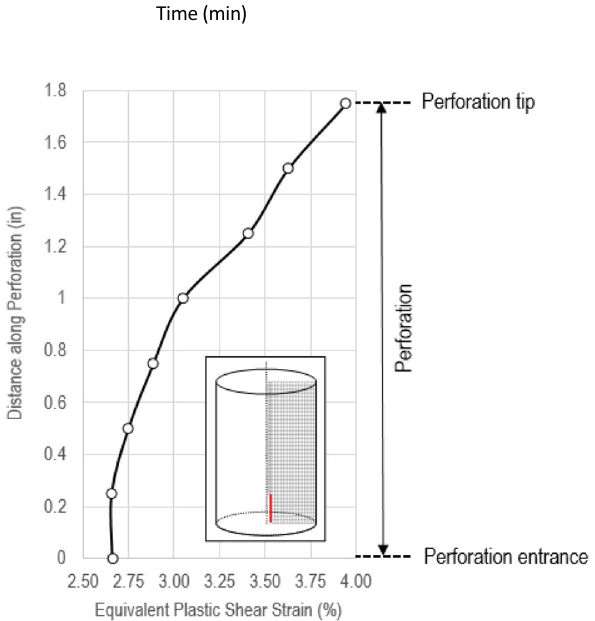
Fig. 18 Equivalent plastic shear strain profile along the perforation at onset of sand